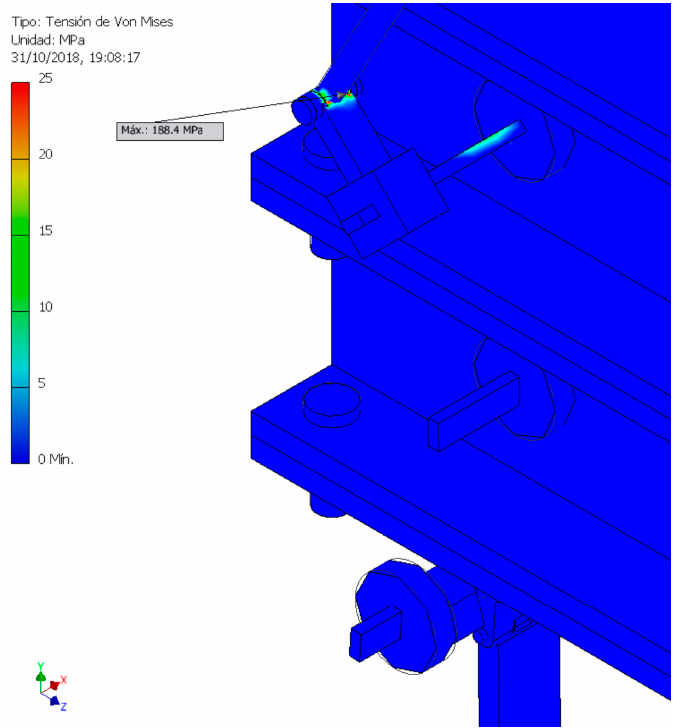
Figure 15. Location of the point where the von Mises stress is maximum.